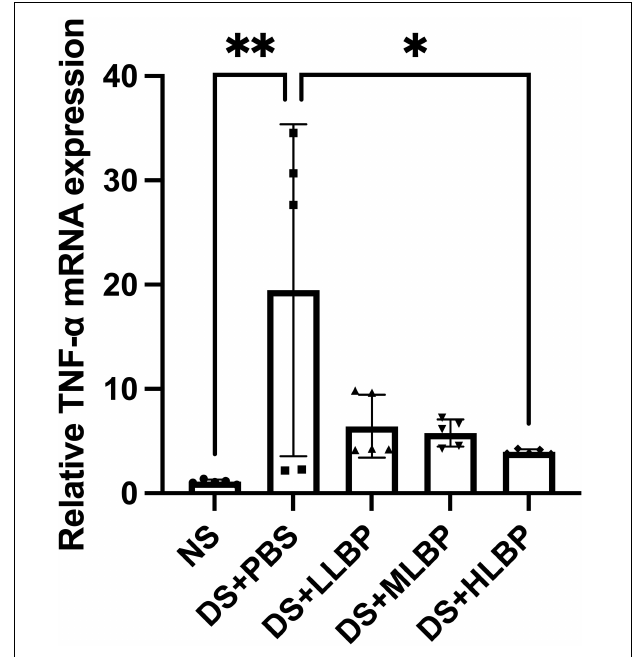
FIGURE 4 | The effects of topical application of LBP on the relative expression level of TNF- α mRNA in the cornea. Data were shown as the mean ± SD. ∗ P < 0.05, ∗∗ P < 0.01.